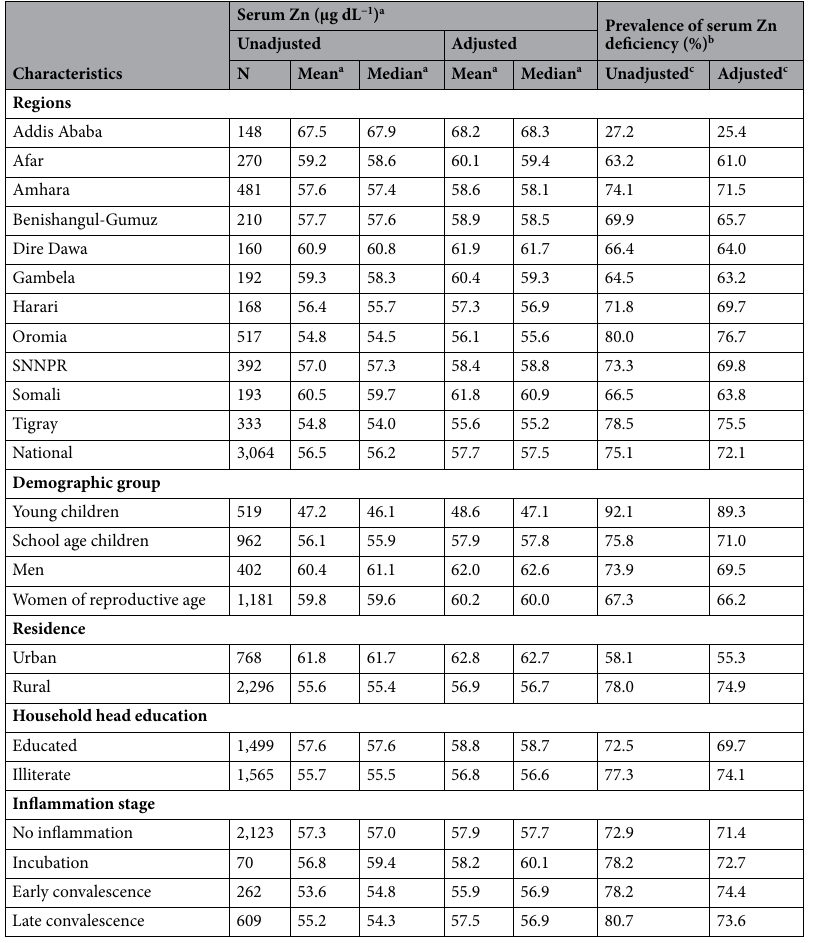
Table 2. Serum Zn concentrations and prevalence of deficiency by study characteristics in the Ethiopian National Micronutrient Survey (ENMS). a The estimation was weighted using the ENMS sampling weight factor. b Zn deficiency was defined based on serum Zn considering age, sex, fasting status and time of blood collection 10 . c BRINDA internal regression correction approach, which accounts for both CRP and AGP, was applied to calculate the prevalence of Zn deficiency (Namaste et al . 2017) 22